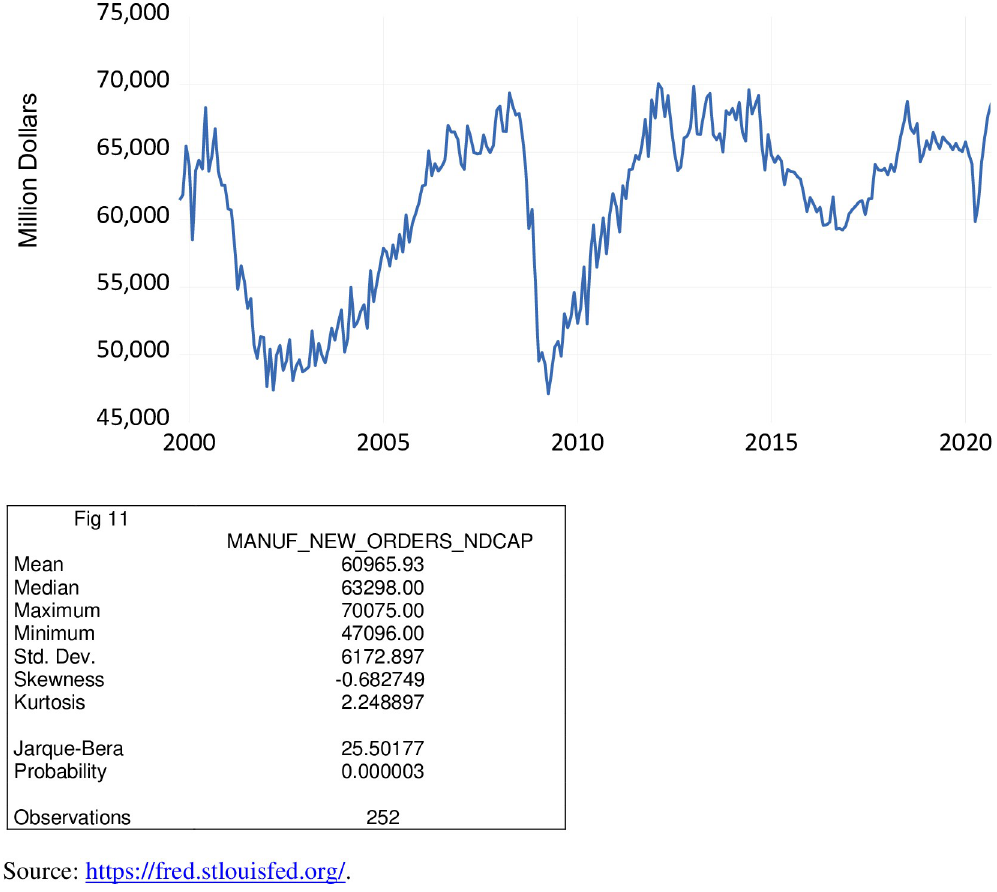
Fig 11. Manufacturers’ new orders of non-defense capital goods, million $, October 1999 to September